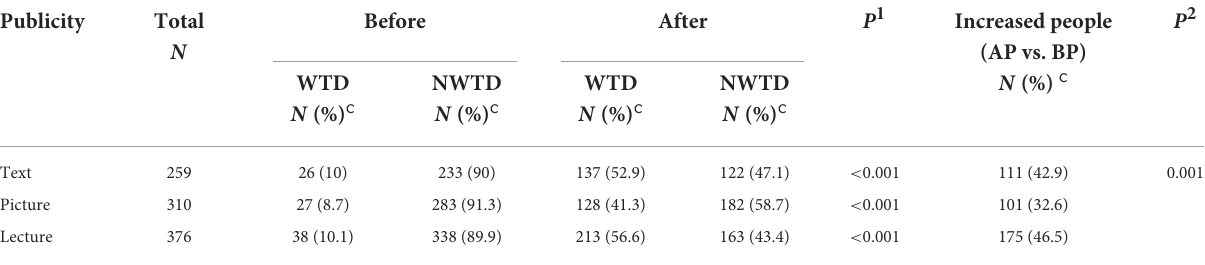
TABLE 2 The effectiveness of different publicity methods in raising people’s donation willingness.